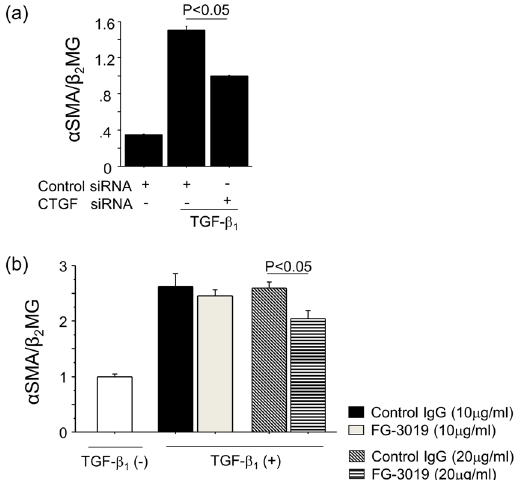
Figure 6. TGF- β 1 -induced myofibroblast differentiation was inhibited by CTGF blockade. ( a ) The effect of CTGF knockdown on TGF- β 1 -induced α SMA expression. NIH3T3 cells were transfected with control siRNA or siRNA targeting CTGF, and then stimulated with TGF- β 1 (5 ng/ml for 6 hrs). Data are expressed as copies of α SMA mRNA relative to copies of β 2 microglobulin mRNA ± SEM. (n = 3 cell preparations/group). ( b ) Effect of CTGF inhibition on TGF- β 1 -induced α SMA expression. NIH3T3 cells were preincubated with the indicated concentration of FG-3019 or control IgG for 1 h, and then stimulated with TGF- β 1 (5 ng/ml for 6 hrs). Data are expressed as copies of α SMA mRNA relative to copies of β 2 microglobulin mRNA ± SEM. (n = 15 cell